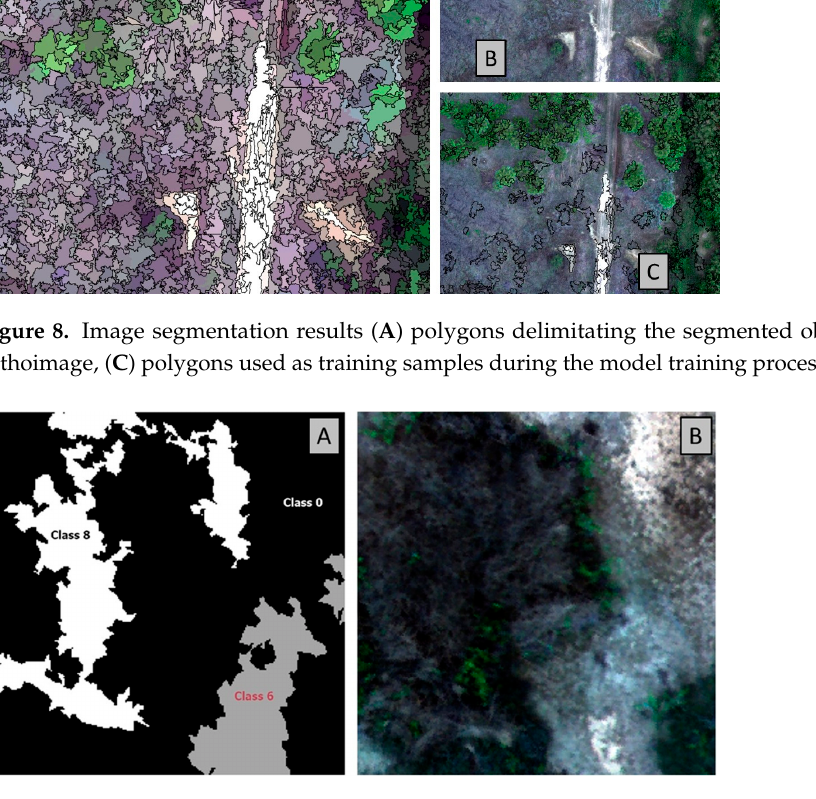
Figure 9. Training tiles ( A ) mask showing the three classes identified and labeled in ( B ) the sample image tile. Class 0 represents the background.